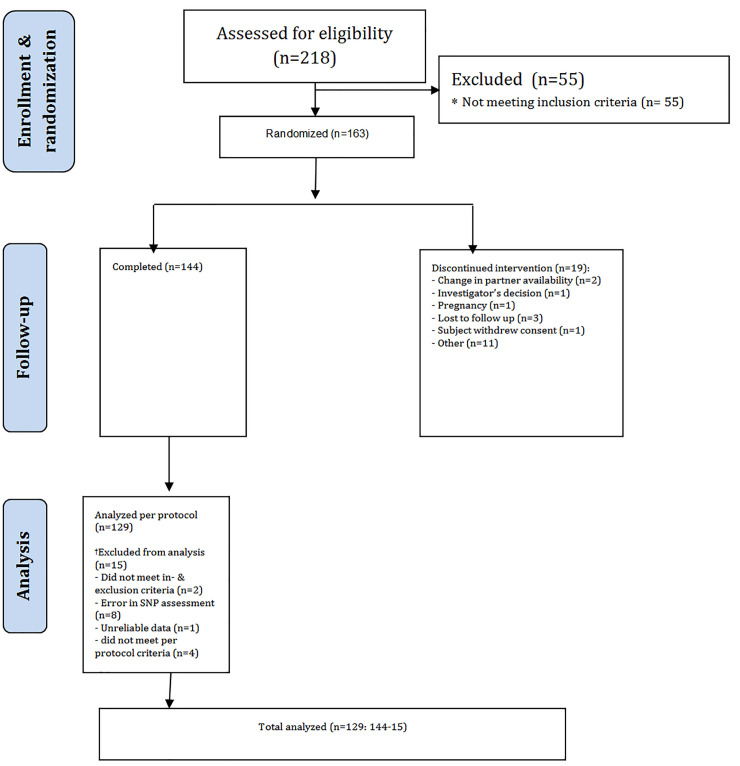
Consort diagram.